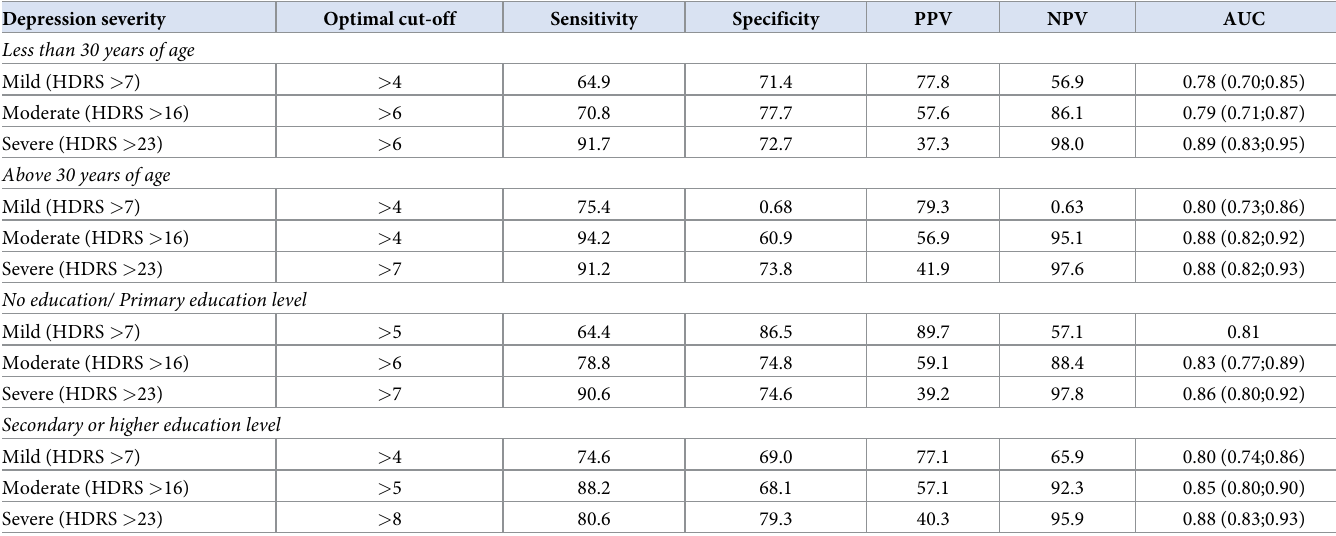
Table 5. Subgroup analysis of optimal cut-offs by age and level of education. Depression